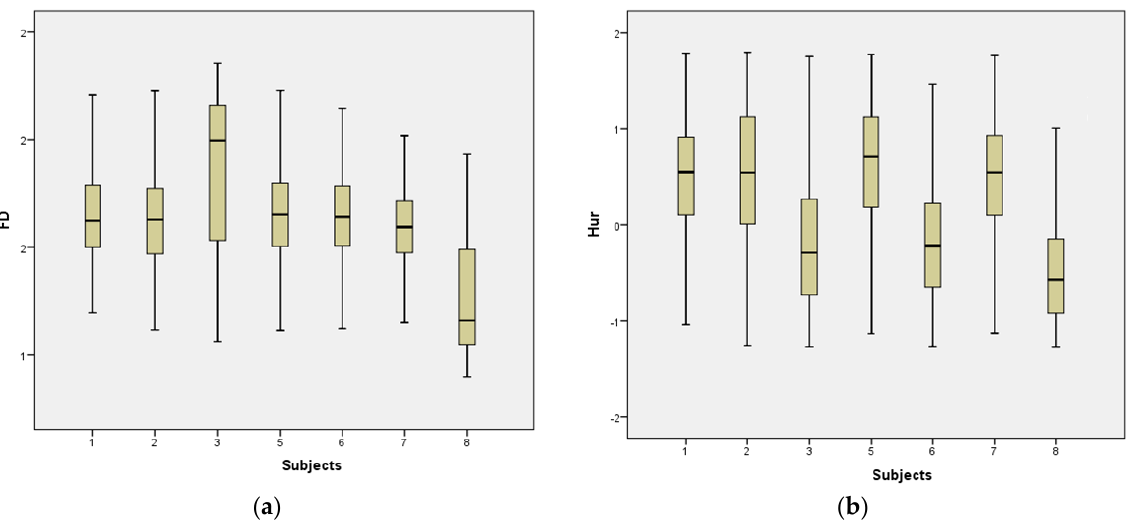
Figure 6. ( a ) The 𝐹𝐷 distribution of features and ( b ) the 𝐻𝑢𝑟 distribution of features for each of the eight people who took part in the EEG MI-based BCI dataset.